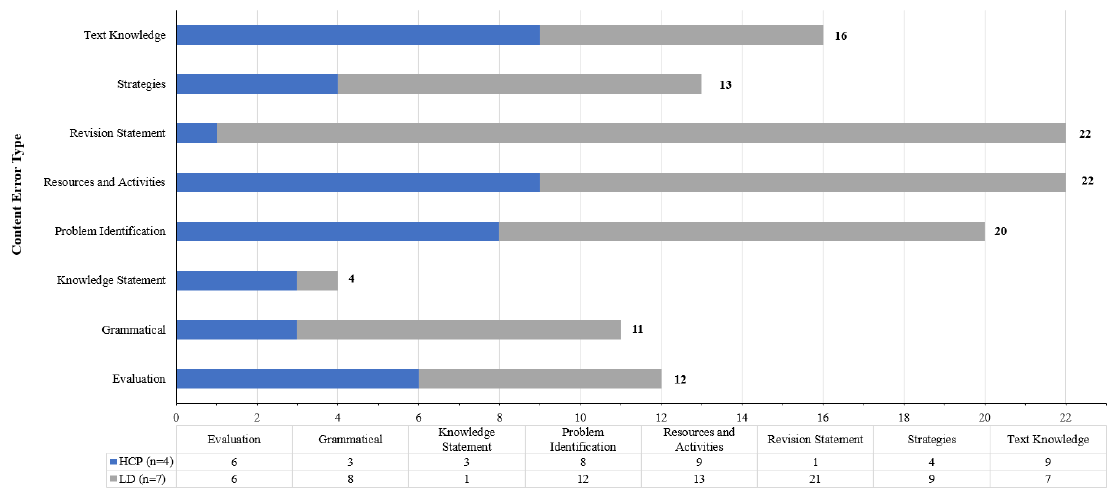
Figure 3. Specific content errors identified by healthcare professionals and Learning Designer evaluator groups.